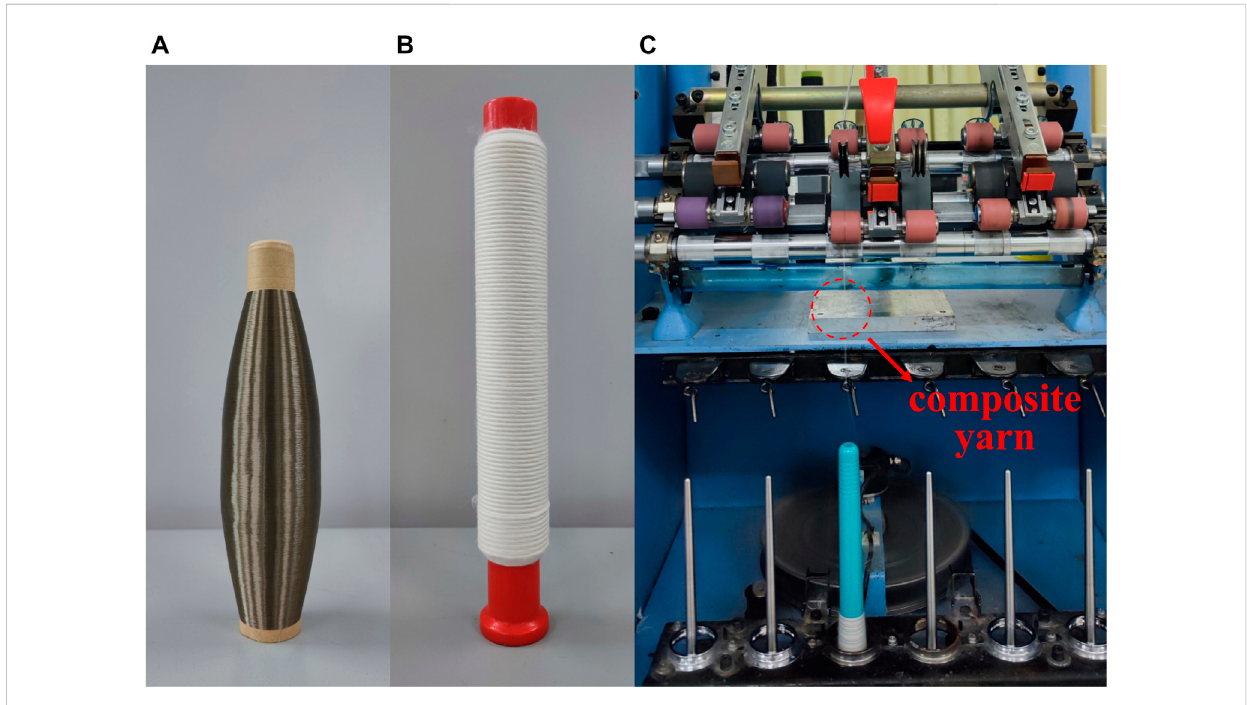
FIGURE 3 Raw materials utilized for the experiments and actual spinning process: (A) basalt fi lament; (B) cotton fi ber and (C) an optic image of ring spinning frame to produce composite yarns.